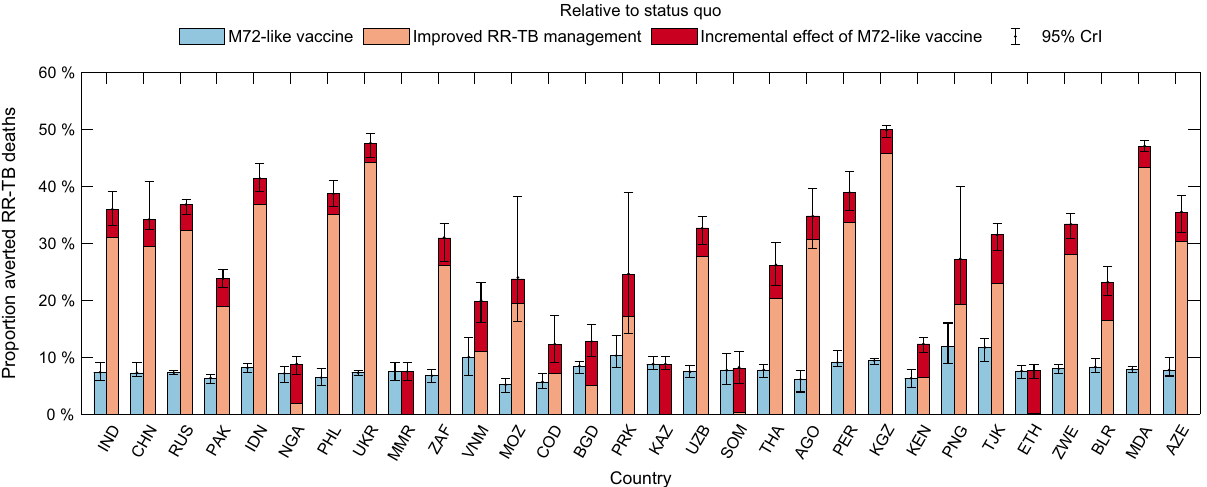
Fig. 5 Projected percent deaths from RR-TB averted, as a result of anti-TB vaccination. Rectangular bars show median estimates and error bars show 95% Bayesian credible intervals (CrIs), both estimated from n = 200 posterior samples for each country. As in Fig. 3, blue bars here show the vaccine- avertable proportions of rifampicin-resistant tuberculosis (RR-TB) deaths relative to a ‘ status quo ’ scenario, while adjacent bars show averted proportions in combination with ‘ improved RR-TB management ’ , as outlined in the caption to Fig. 1. The latter bars are strati fi ed to show: (i) the impact of